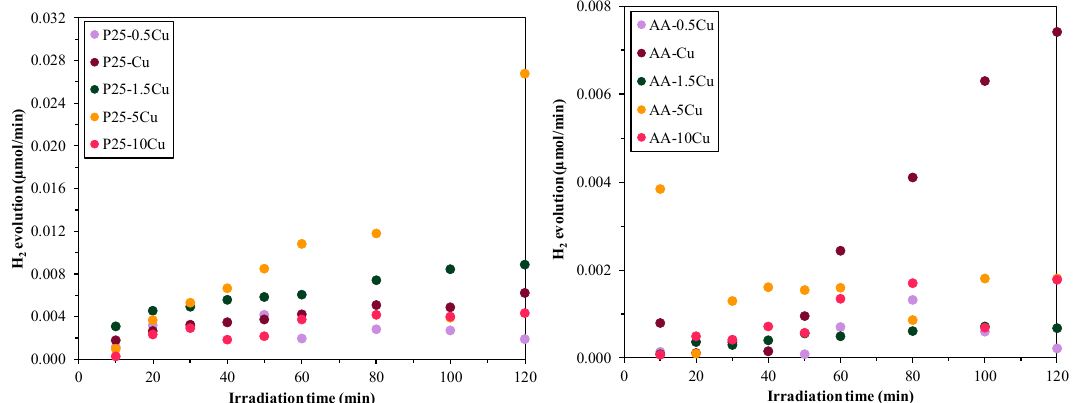
Figure 9. H 2 evolution of the composites (P25—left-hand image; AA—right-hand image), showing the enhanced H 2 production of P25-based composites.